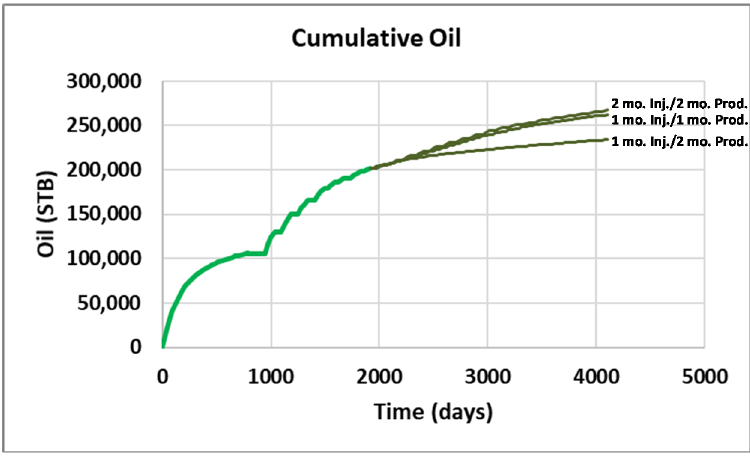
Figure 23. Cycle time sensitivity for huff-n-puff gas injection.